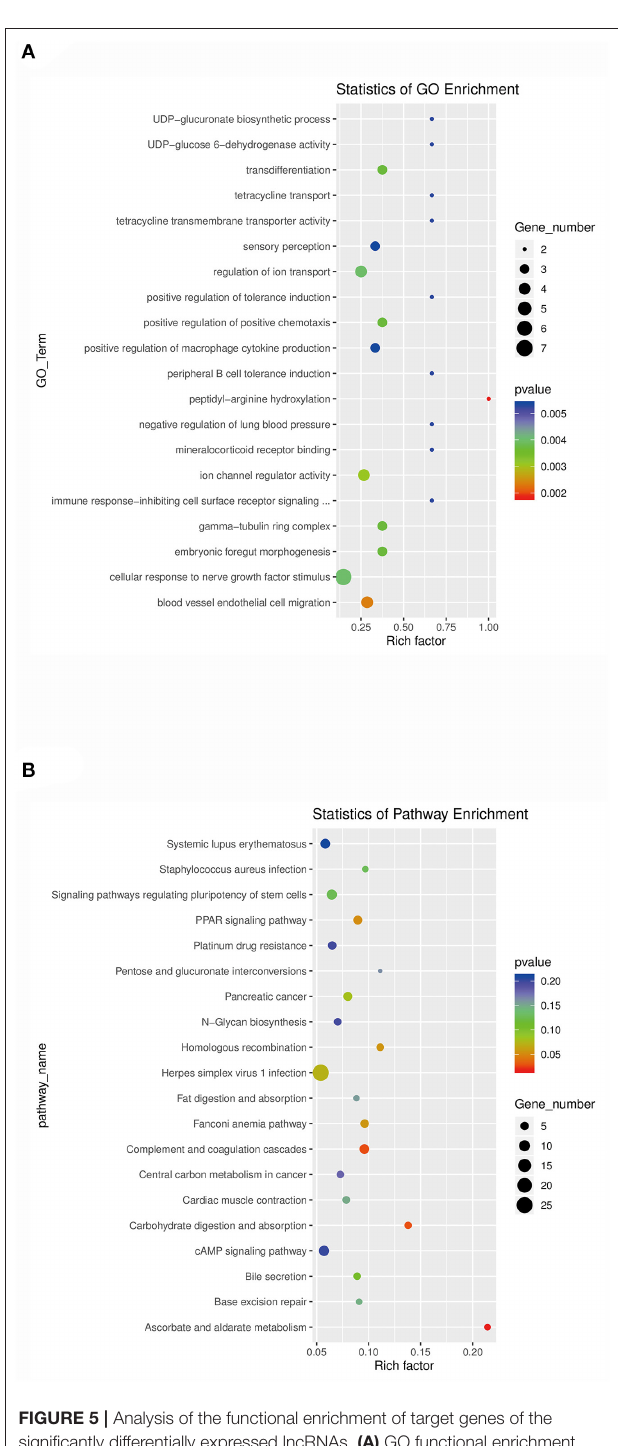
FIGURE 5 | Analysis of the functional enrichment of target genes of the significantly differentially expressed lncRNAs. (A) GO functional enrichment analysis of the predicted target genes of the differentially expressed lncRNAs. y-axis: GO terms; x-axis: rich factor. The color of each bubble represents the p -value, and the bubble size represents the gene number. (B) KEGG pathway enrichment analysis of the predicted target genes of the differentially expressed lncRNAs. y-axis: pathway name; x-axis: rich factor. The color of each bubble represents the p -value, and the bubble size represents the gene